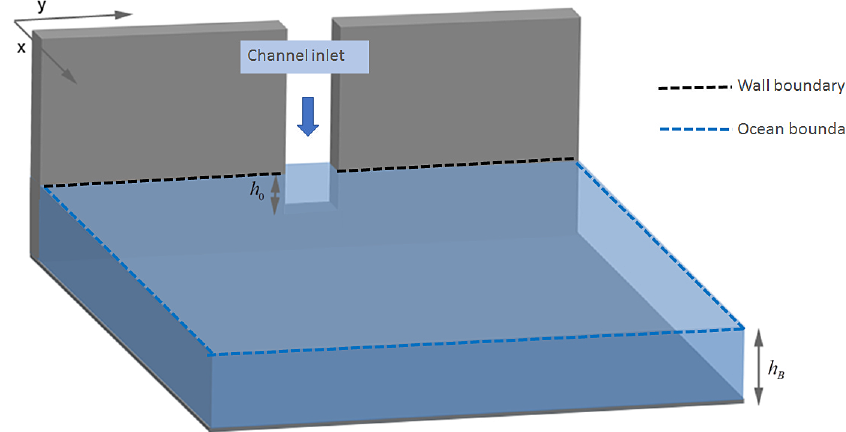
Figure 1. Illustration of the basin, boundaries and inlet channel.